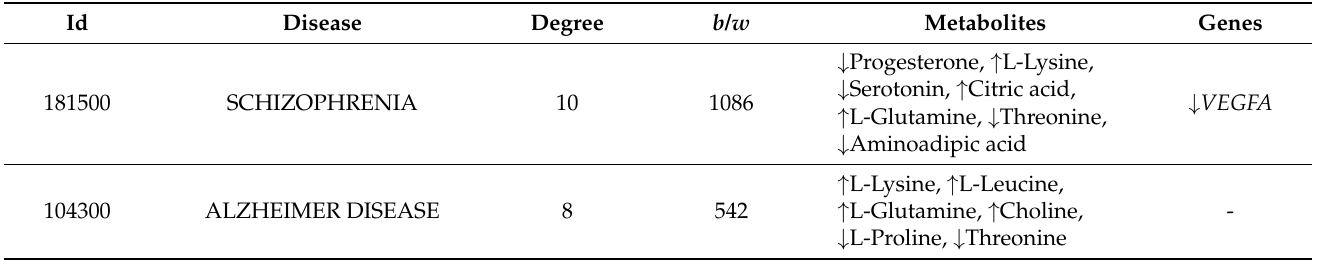
Figure 9. KEGG-based interaction network analysis among metabolites, genes, and diseases, where different shapes of nodes denote different characters, and the lines between different nodes show the connections. Table 6. Major diseases and their directly-associated metabolites and genes from the network analysis are listed. “Degree” denotes the number of direct connections among nodes and “Betweenness” shows the centrality of the given interaction. The list of interaction network nodes is given against each corresponding disease along with its regulation status in the heat-stressed granulosa